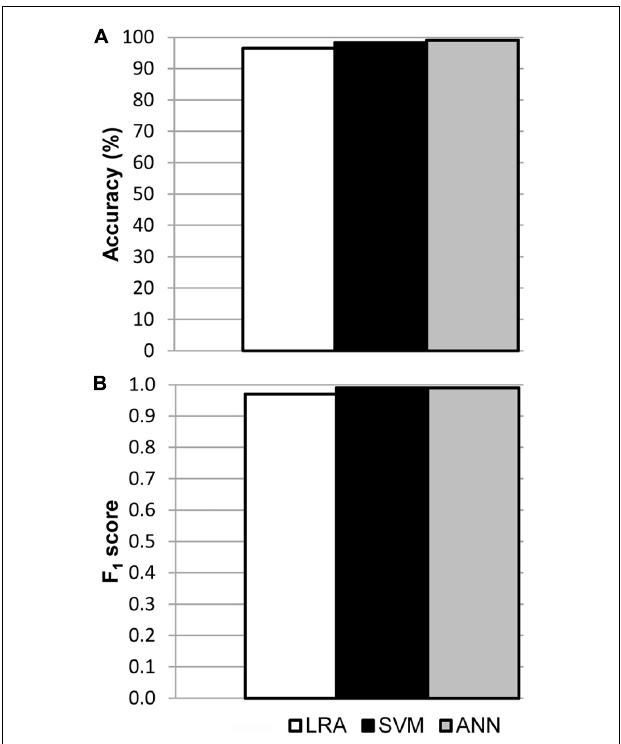
FIGURE 4 | Results of the validation of the I area models used to classify healthy and D. dadantii -infected I areas. Classifiers were trained and tested combining data from the mock-control, LD, and HD infiltrated areas, at every day post-inoculation assayed. (A) Accuracy of the models. (B) F 1 score of the classifiers. n test = 119 for LRA, 120 for SVM, and 117 for